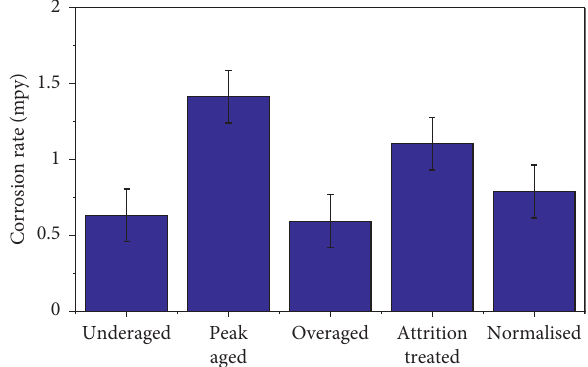
Figure 7: Corrosion rates of 6351 Al alloy in Red Sea water.